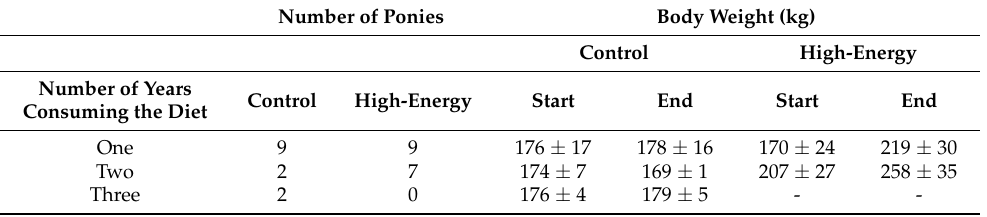
Table 4. Mean ± SD weight (kg) of Shetland pony mares (total n = 18) at the start and end of the first, second and third years that were fed a control (maintenance) or a high-energy (200% of net energy requirements)